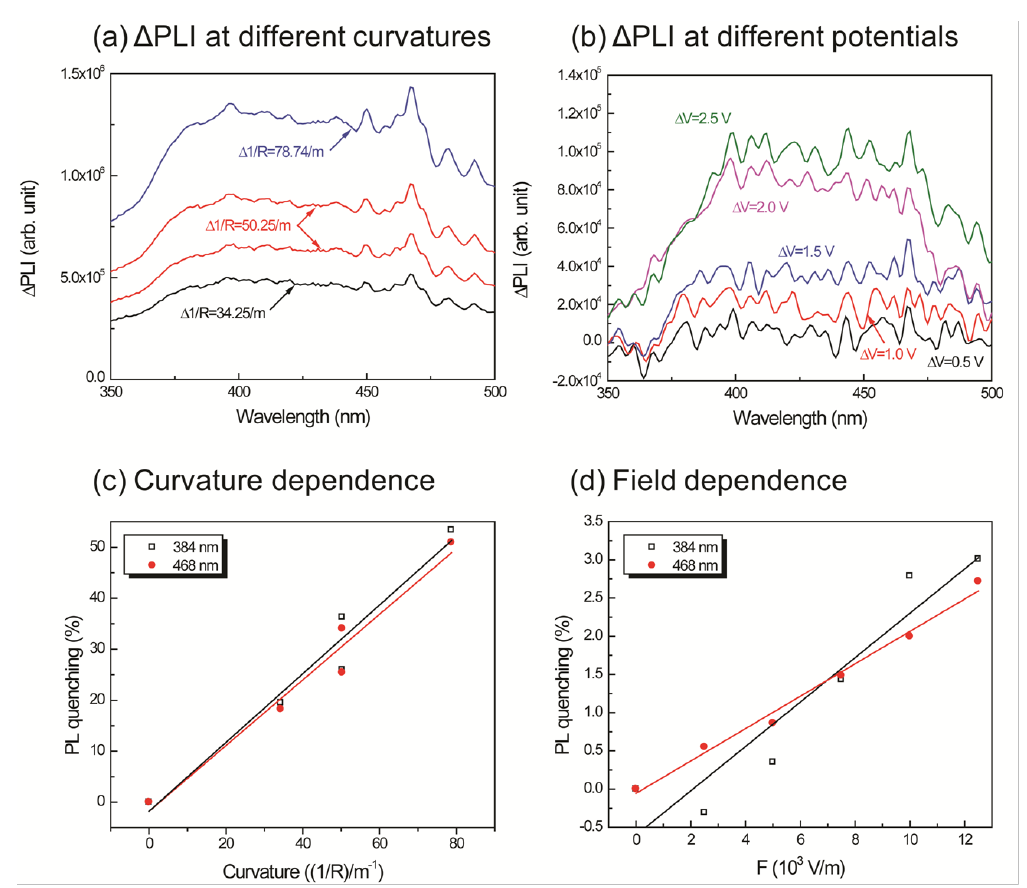
Figure 7. Change in PL intensity with change in curvature (a) , and change in input potential (b) and respective PL quenching efficiency (c) and (d)